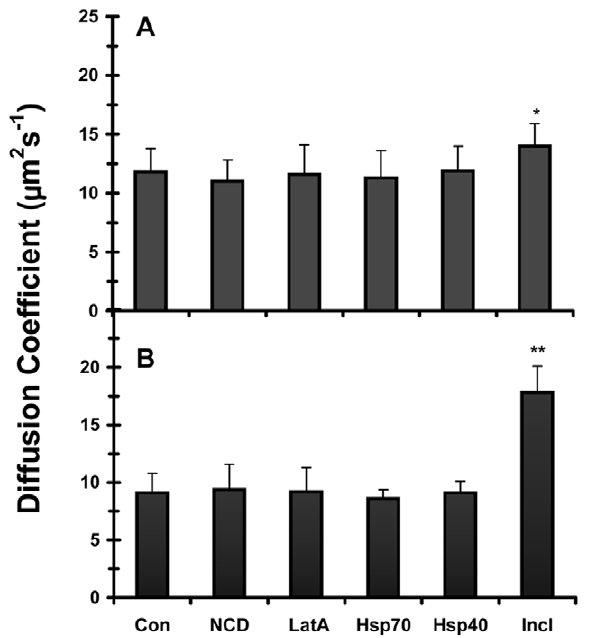
Figure 3. Diffusion coefficient of HttQP fragments measured under different conditions. The diffusion coefficients of cytosolic HttQP25 (panel A) and HttQP103 (panel B) were measured in control cells (Con), nocadozole-treated cells (NCD), Latrunculin A-treated cells (LatA), cells cotransfected with Hsp70 (Hsp70), cells cotransfected with Hsp40 (Hsp40), and cells with an inclusion (Incl). To obtain inclusions in HttQP25 expressing cells, cells were cotransfected with GFP-labeled HttQP25 and non-fluorescent HttQP103. FCS measurements were made 72h after transfection. Diffusion coefficients and standard deviations were calculated as described in Figure 1. *, p , 0.05 and **, p , 0.005 versus control cells by Student’s t -test.